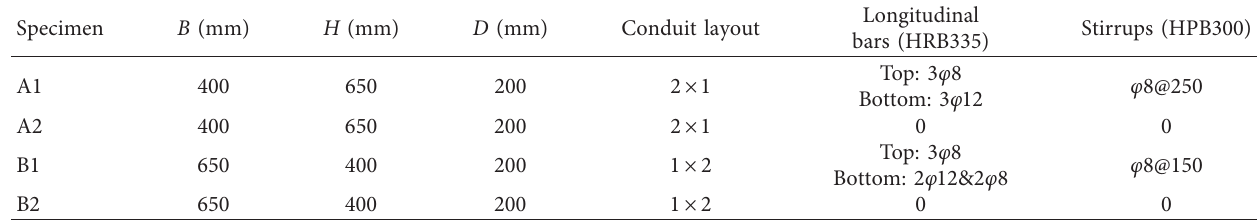
Table 2: Geometric dimensions and reinforcement specifications for